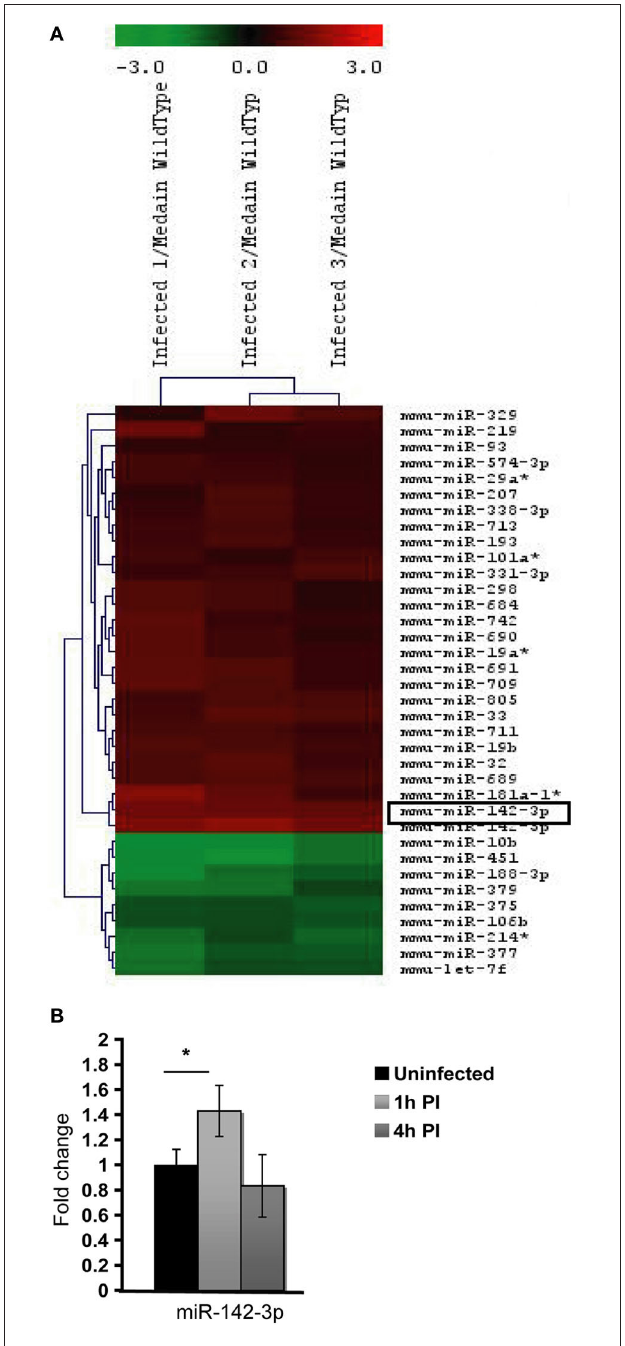
FIGURE 1 | MicroRNA Expression in J774A.1 Macrophages infected with M. smegmatis for 1h. (A) Heatmap of the most significantly regulated genes. The median normalized intensity values for each of the three infected replicates were divided by the median of the uninfected (wild type) samples. The ratio was then converted to log2 space and changes in the expression ratio were analysed using the Significance Analysis of Microarrays Test to isolate those with significant changes, FDR < 1%. (B) Relative expression of miR-142-3p in mouse cells infected with M. smegmatis at MOI 10, as measured by qPCR analysis. Data is represented as the mean fold change per sample ± SD at 1 and 4h post-infection ( ∗ P ≤ 0 .